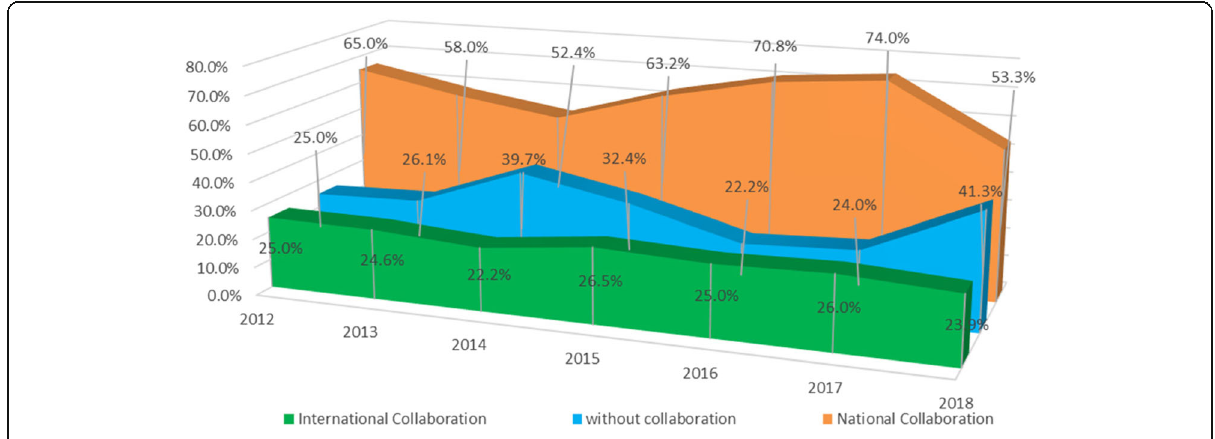
Fig. 4 Annual evolution of collaboration between institutions (source: Scopus